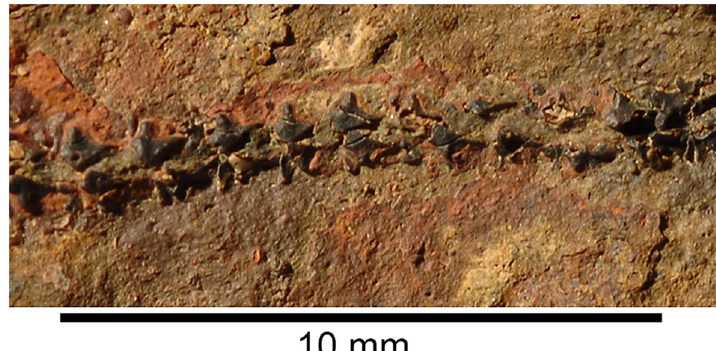
Fig. 12 Detail of thorax of Maghriboselache mohamezanei n. gen. et sp., PIMUZ A/I 5156, showing the modified scales of the lateral